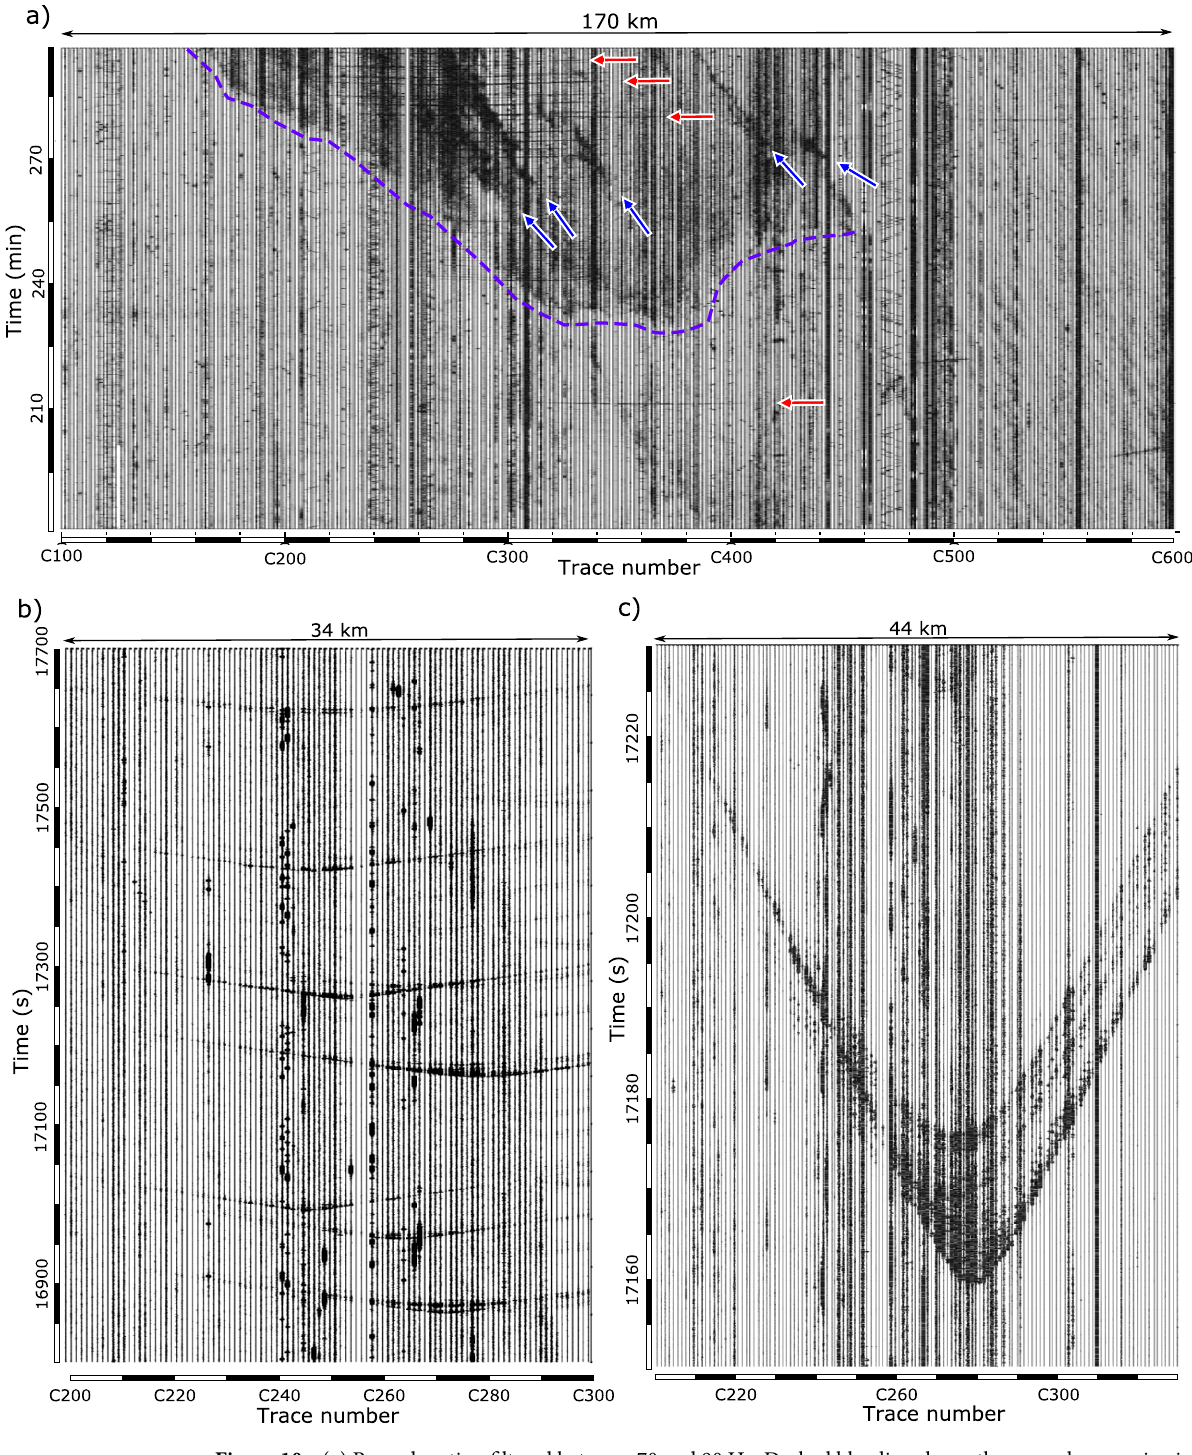
Figure 10. ( a ) Record section filtered between 70 and 90 Hz. Dashed blue line shows the area where a seismic amplitude increase associated with rainfall is detected. Blue arrows mark some of the signals related to wind gusts. Red arrows show some examples of signals related to thunders. ( b ) Selected section showing up to 7 events interpreted as due to thunders ( c ) Detail on the records of one of the thunder events. The distance range covered by each section is shown on top of the